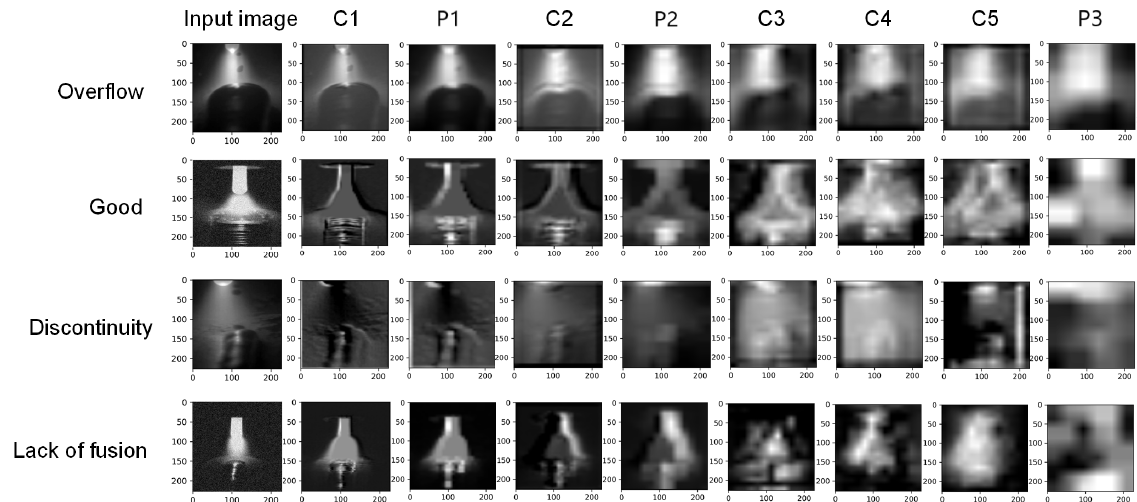
Figure 11. The feature maps of four samples representing “overflow”, “good”, “discontinuity” and “lack of fusion” after having been learned by different layers.